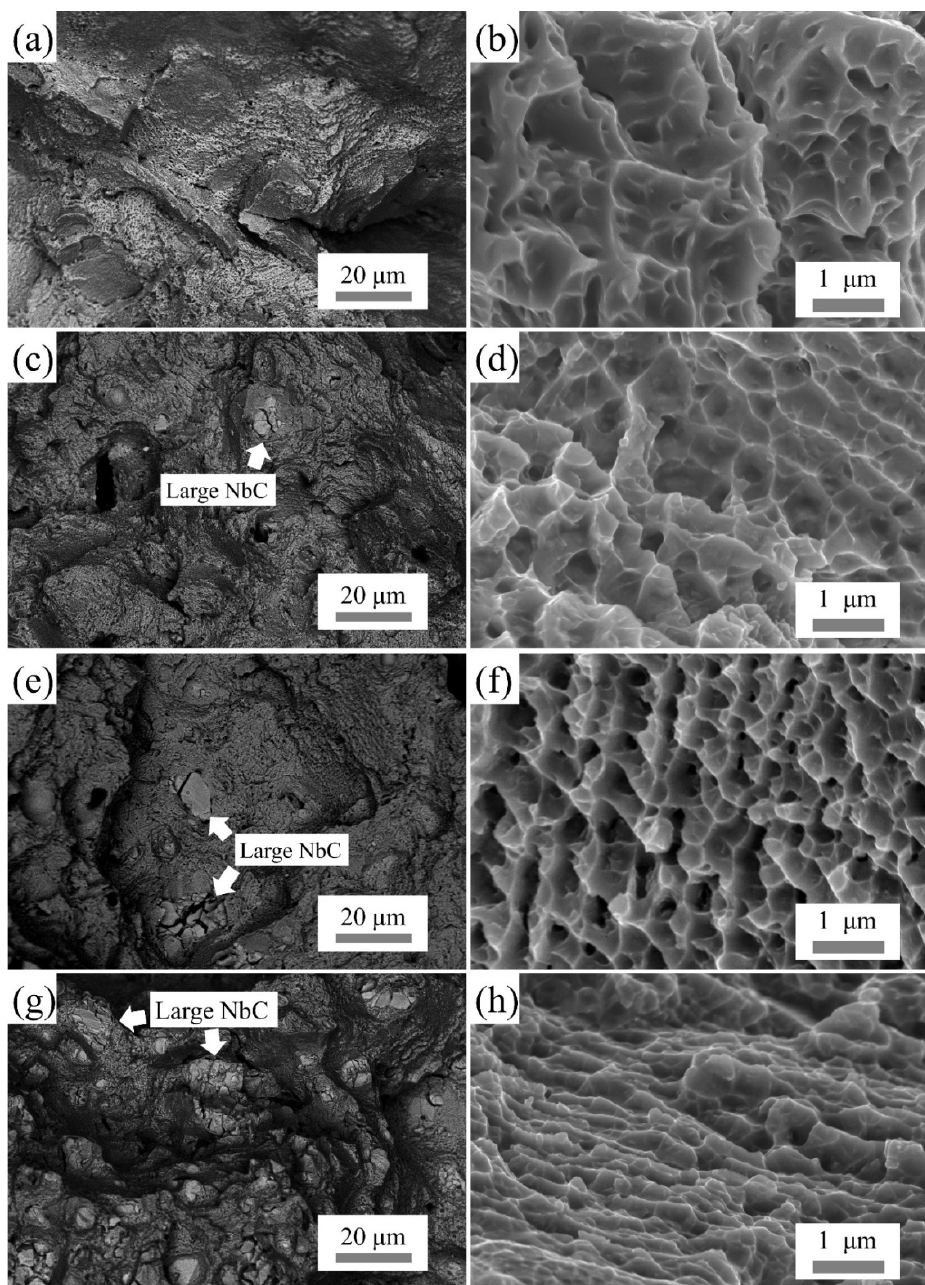
Figure 12. Fracture surfaces of DA specimens. ( a , b ) without NbC, ( c , d ) 0.5% NbC, ( e , f ) 1.0% NbC, and ( g , h ) 5.0% NbC.